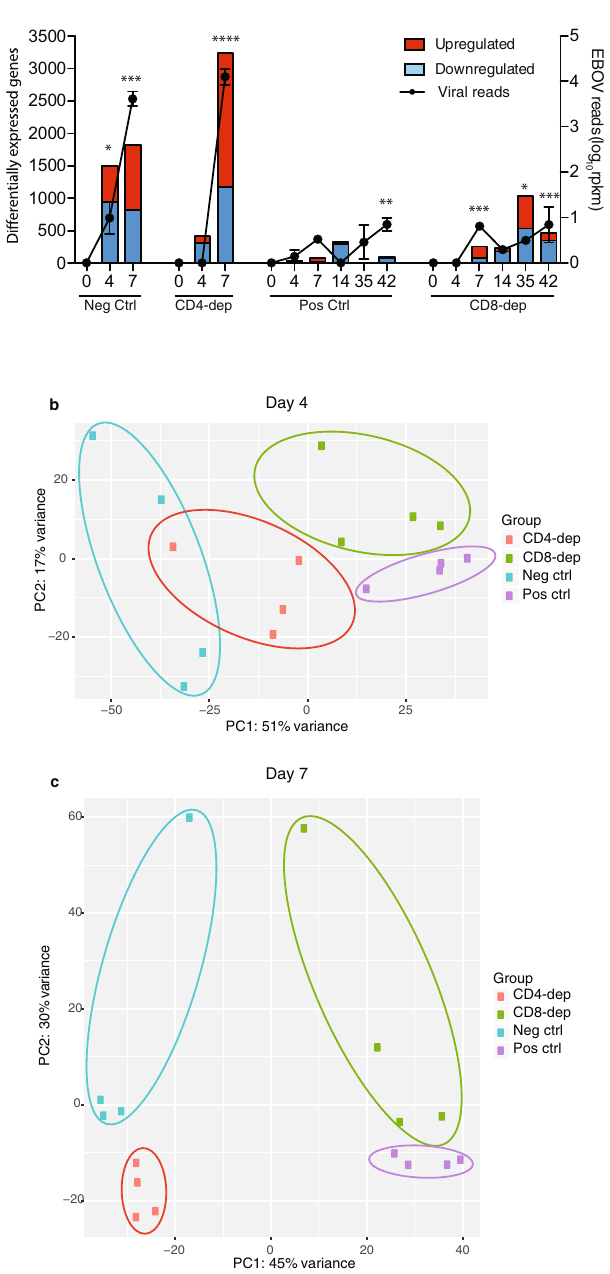
Figure 2. EBOV challenge results in larger transcriptional changes in animals that succumb to infection compared to those that survive. ( a ) Bar graph: Number of DEGs detected 4, 7 (or the day animals were necropsied), 14, 35 and 42 dpi in negative control, CD4-depleted, positive control, and CD8-depleted animals. Line graph: Total number of RPKM normalized transcripts mapping to the Kikwit-ZEBOV genome. Longitudinal changes of EBOV transcripts were carried out using one-way repeated measures ANOVA test followed by Dunnett’s multiple comparison post-test to determine differences between day 0 and subsequent days post-infection; * p < 0.05; ** p < 0.01; *** p < 0.001; **** p < 0.0001; n = 4 in all groups. ( b , c ) Principal component analysis of all 4 groups 4 (B) and 7 (C)